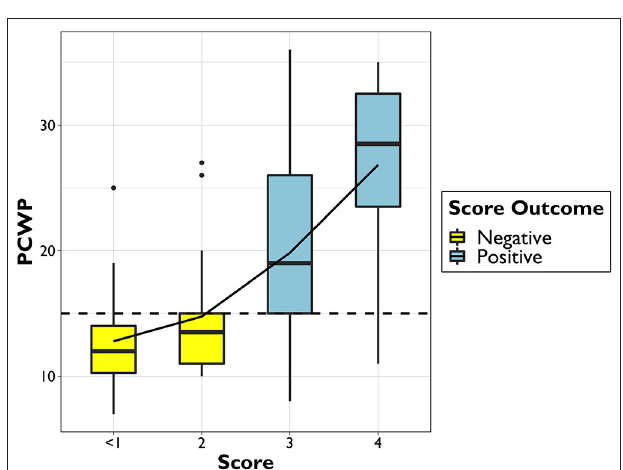
FIGURE 5 | Boxplot of PCWP distribution among different scoring points. PCWP, postcapillary wedge